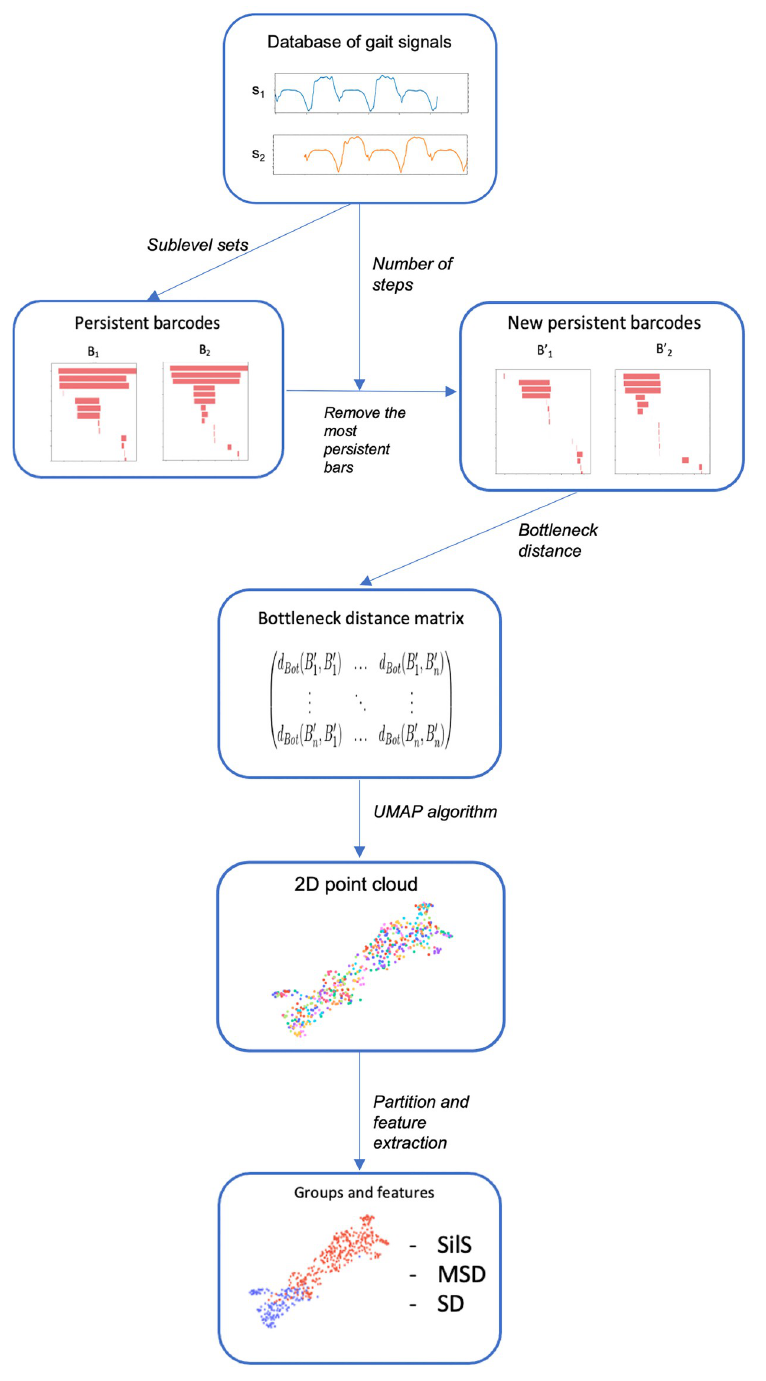
Fig 4. Summary of our